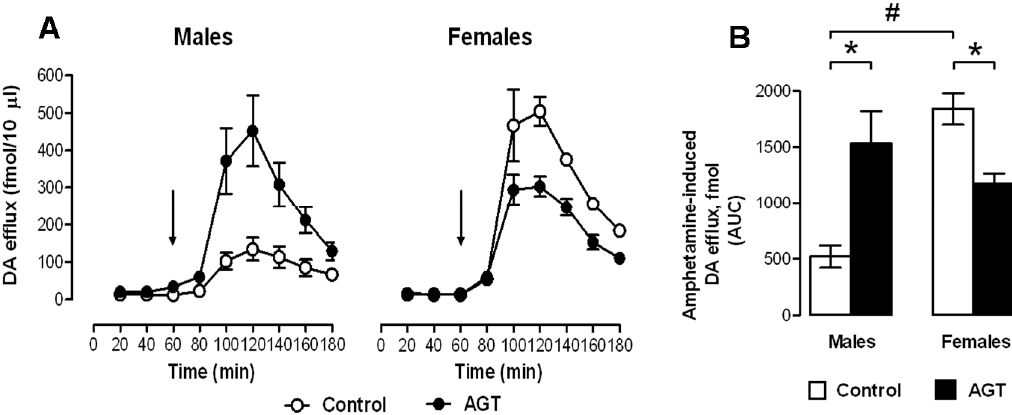
Figure 5. Impact of AGT on the neurochemical response to amphetamine. Male and female rats exposed to antenatal glucocorticoid treatment (AGT; dexamethasone, 0.5 µg/mL, in dams’ drinking water on gestational days 16–19) and controls (dams received normal drinking water) were tested in adulthood. Extracellular levels of DA (dopamine) in the NAc (nucleus accumbens) were assessed by in vivo microdialysis coupled with electrochemical detection; samples were collected every 20 min. ( A ) the line plots depict DA levels in each 20-min fraction for controls (pen circles) and AGT subject (solid circles); the arrow indicates the point of amphetamine administration (0.8 mg/kg i.p .); ( B ) The bar plot shows cumulative DA release above baseline (area under the curve, AUC). Values represent means ± s.e.m for control males ( n = 5), AGT males ( n = 6), control females ( n = 4) and AGT females ( n = 5) ( n values vary according to correct placement of dialysis probe and statistical analyses were adjusted accordingly). # p < 0.05, indicating a significant sex difference; * p < 0.05 indicating a significant effect of AGT. For full details see [119].